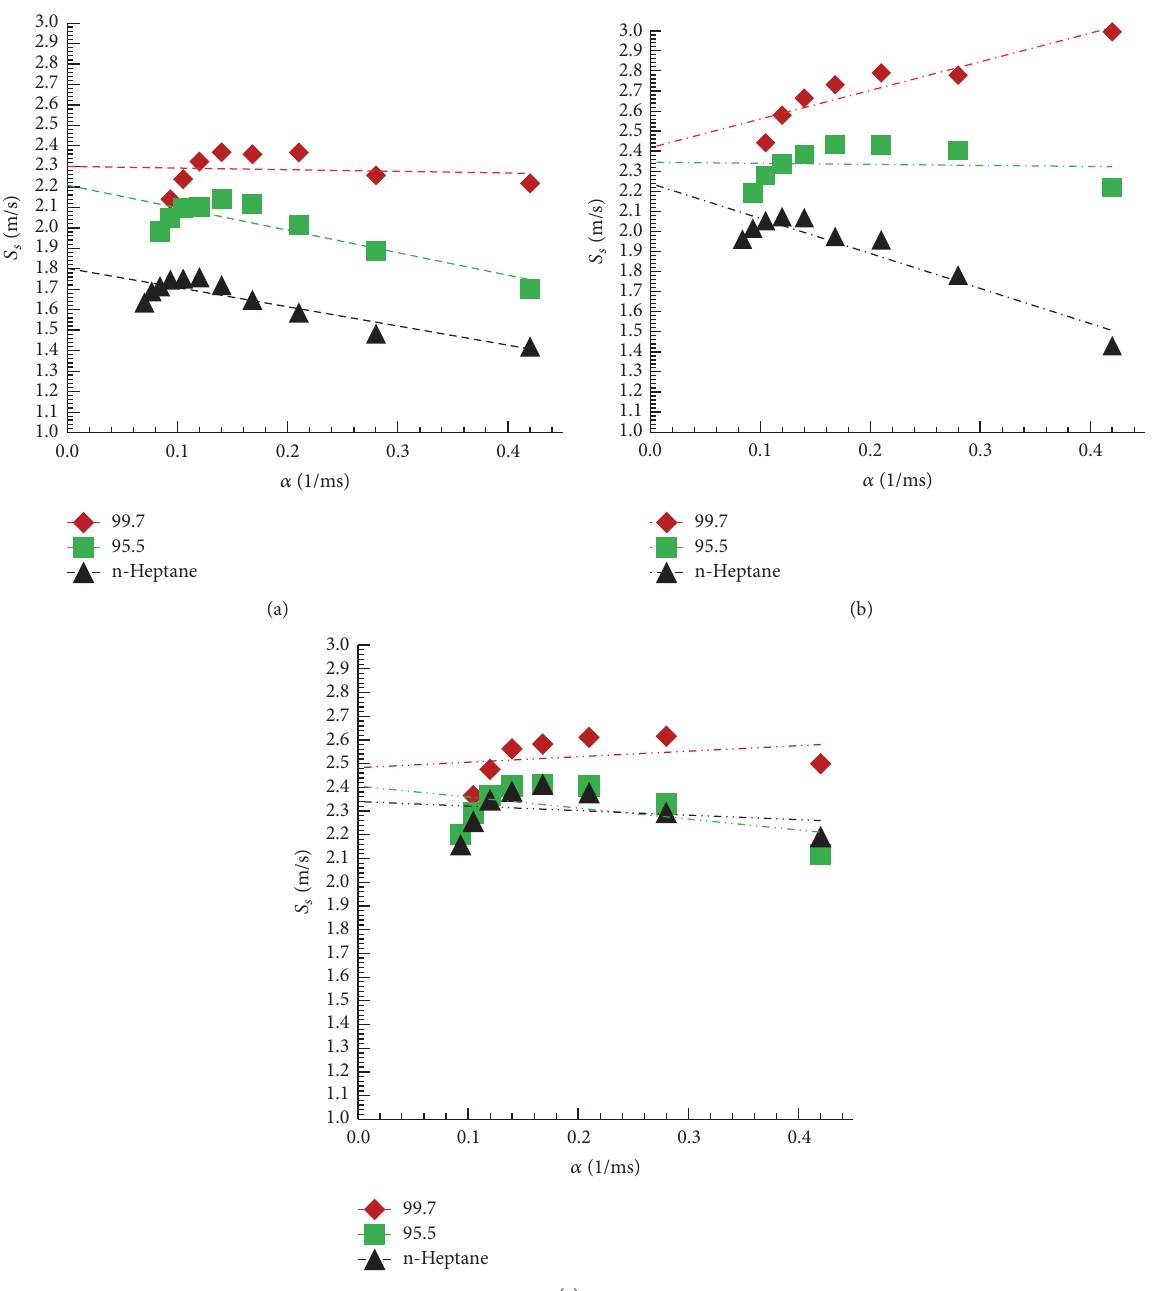
Figure 4: Flame stretch rate for the hydrous ethanol, anhydrous ethanol, and n-heptane. (a) Stoichiometric mixture; (b) rich mixture; (c) very rich